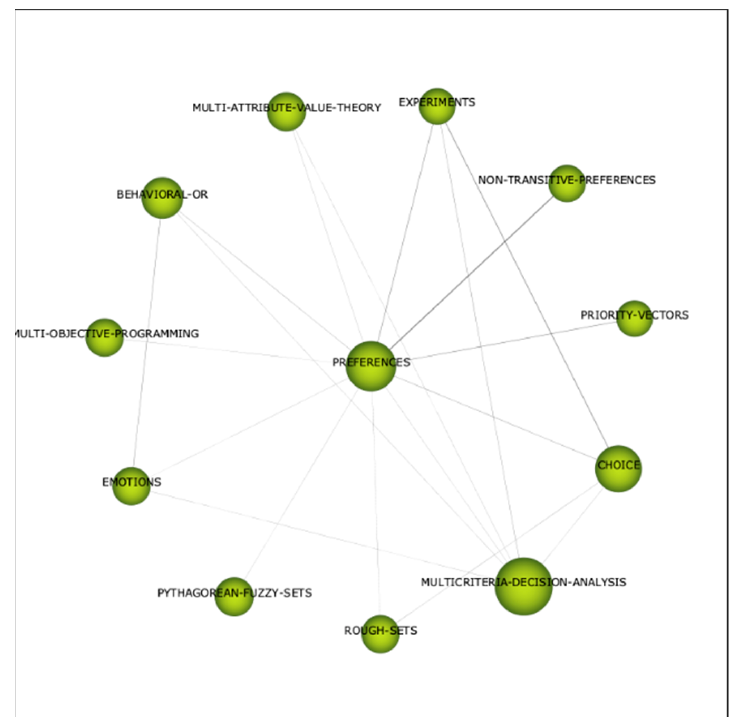
Figure A3. Preference cluster network.